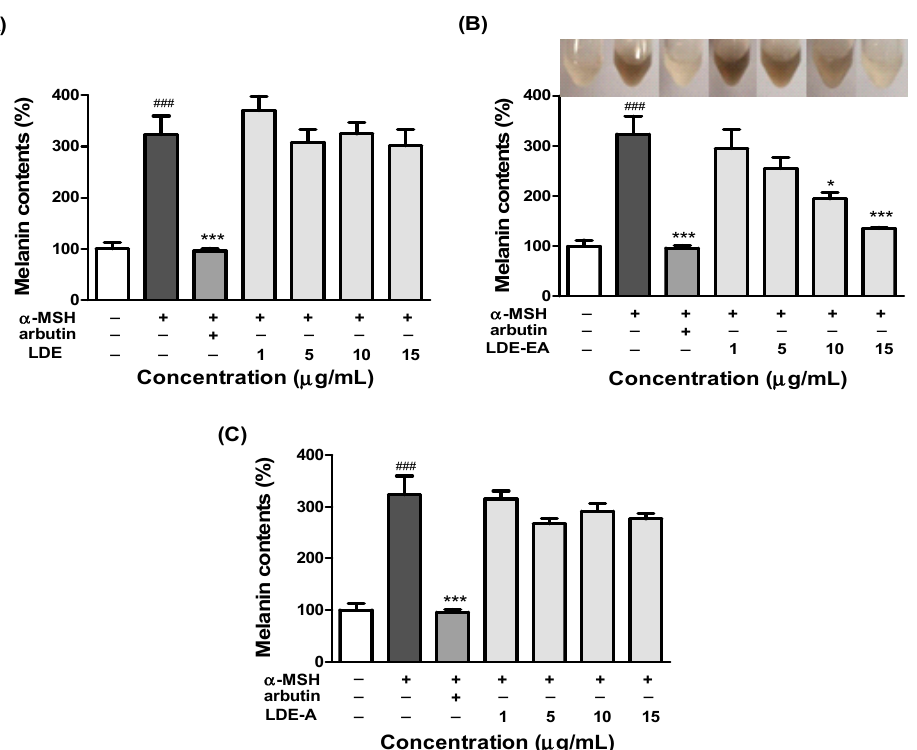
Figure 2. Effect of L. difformis extract on melanogenesis in B16F10 cells. B16F10 cells were exposed to 200 nM α -MSH in the presence of 1, 5, 10, and 15 µ g/mL L. difformis extract (( A ) LDE, ( B ) LDE-EA, and ( C ) LDE-A) or 1 mM arbutin (a melanin inhibitor). Each percentage value for the treated cells was reported relative to that of the control cells. Values are represented as the mean ± SEM of three independent experiments. Note: ### p <0.001 compared with the control; * p < 0.05, and *** p < 0.001 compared with the α -MSH-treated control.